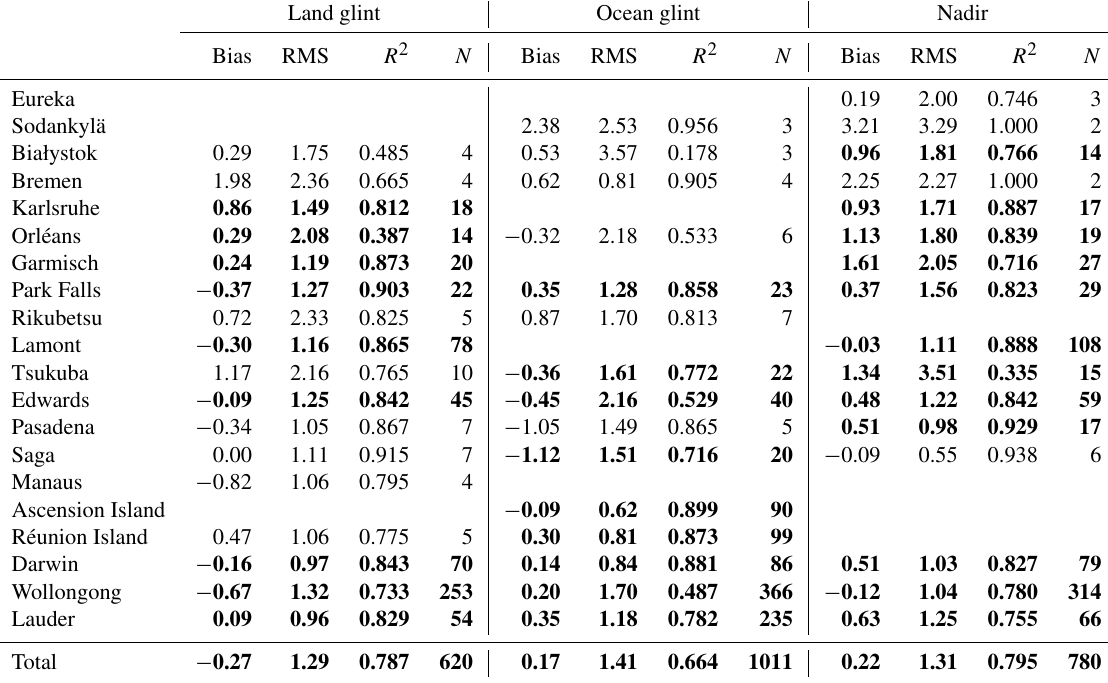
Table 3. Glint and nadir statistics for data filtered using warn levels ≤ 11 and the xco2_quality_flag = 0. The median bias (OCO-2 − TCCON) and its RMS, R 2 and number of daily median comparison points, or “coincidences” ( N ) are listed below for each TCCON station. If the number of coincidences is larger than 10, the results are marked in bold font. The “Total” row is calculated by considering all the coincidences in the table